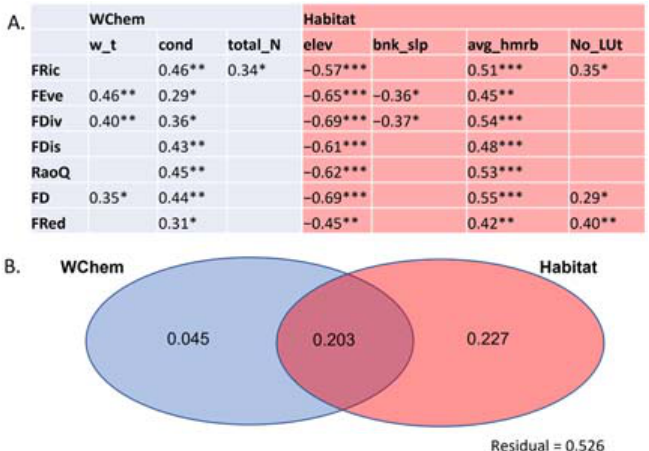
Figure 3. ( A ) Statistically significant coefficients of linear correlation between functional diversity indices and environmental variables ( p < 0.001—***; p < 0.01—**; p < 0.05—*). ( B ) Venn diagrams of variation partitioning. The abbreviated names of the environmental variables are given in Table 1, and those of the functional diversity indices in Table 3.